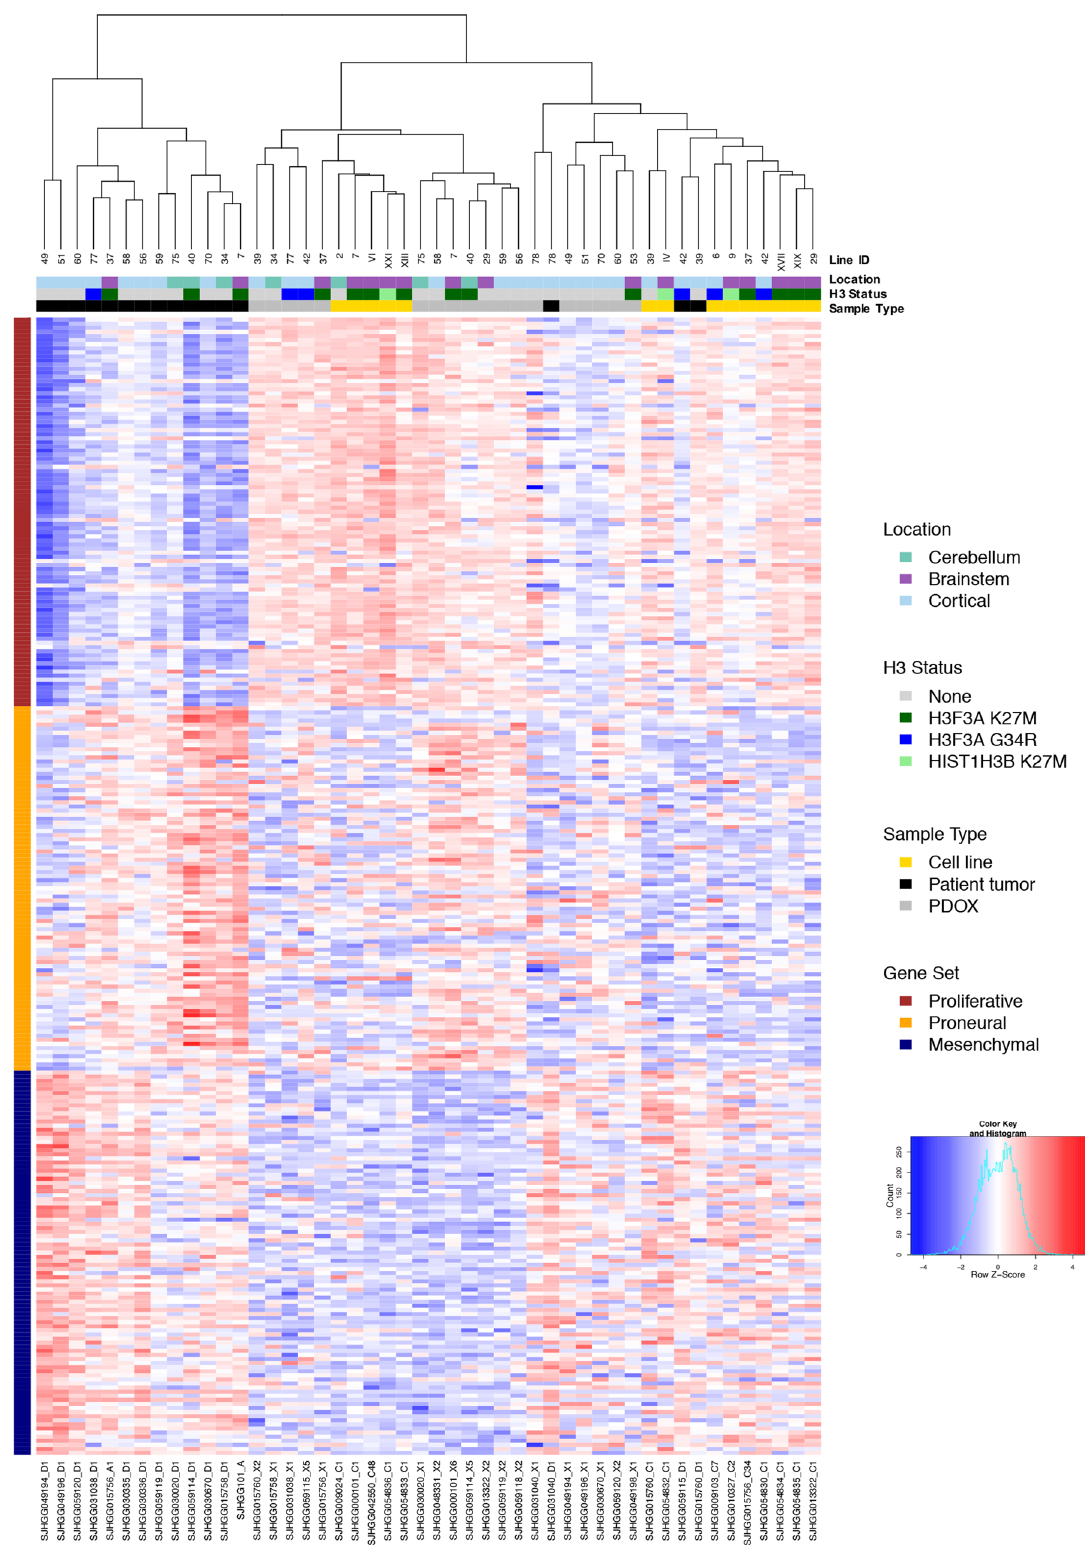
Fig. 5 Gene expression signatures of PDOX models recapitulate glioma expression subgroups. Unsupervised hierarchical clustering of RNA-seq quanti fi cation (log CPM) of genes from three expression signatures recapitulating glioma subgroups proliferative, proneural, and mesenchymal across the patient tumors, PDOXs, and cell